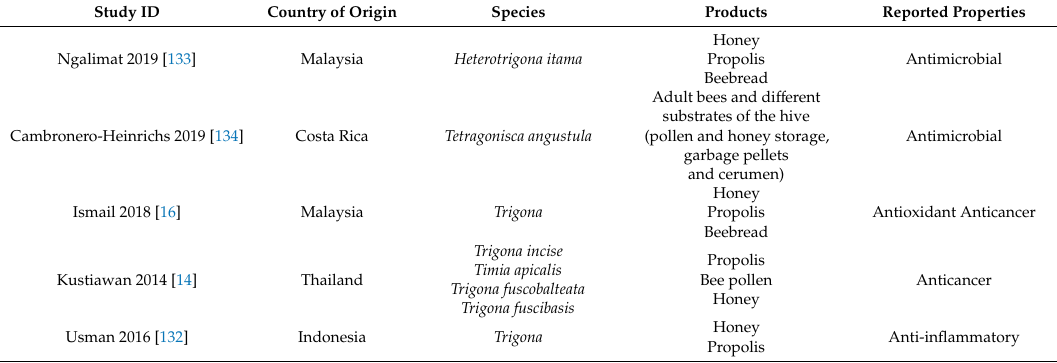
Table 4. List of studies on the potential medicinal properties of di ff erent stingless bee